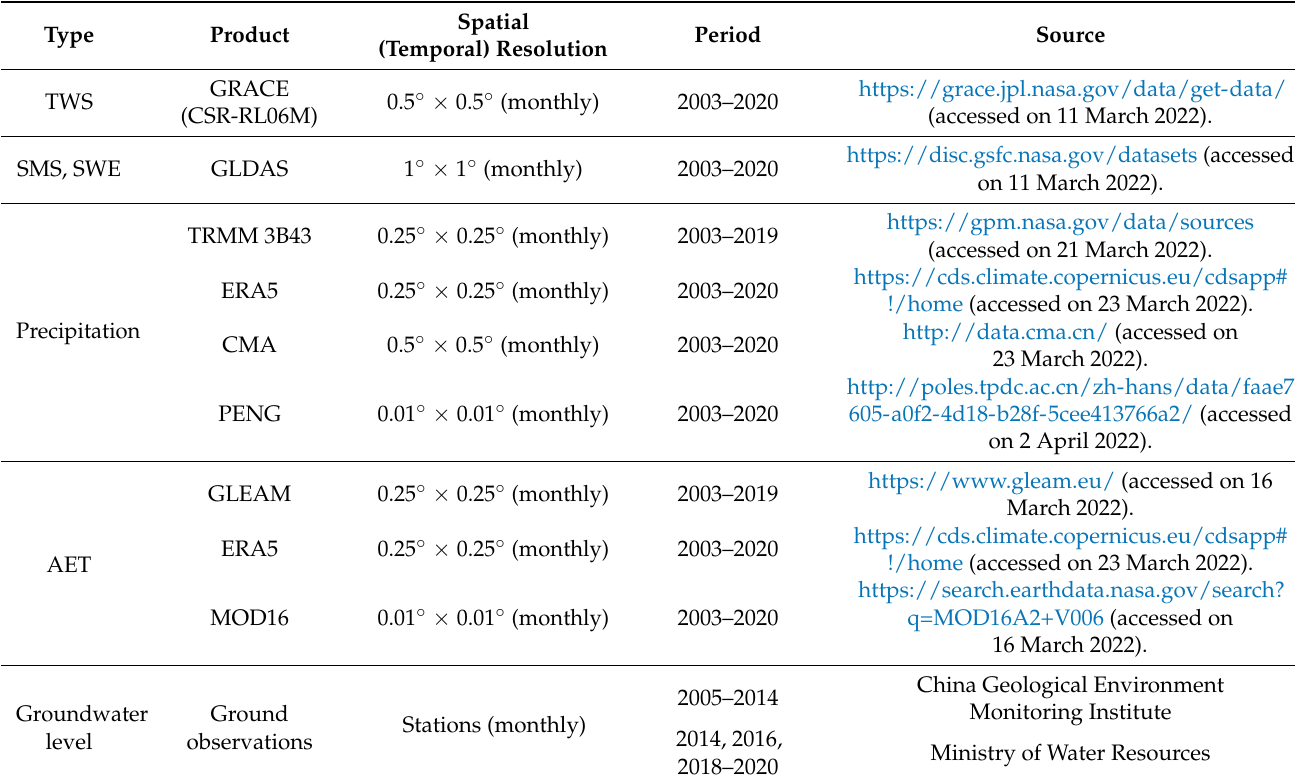
Table 1. Summary of data used in the